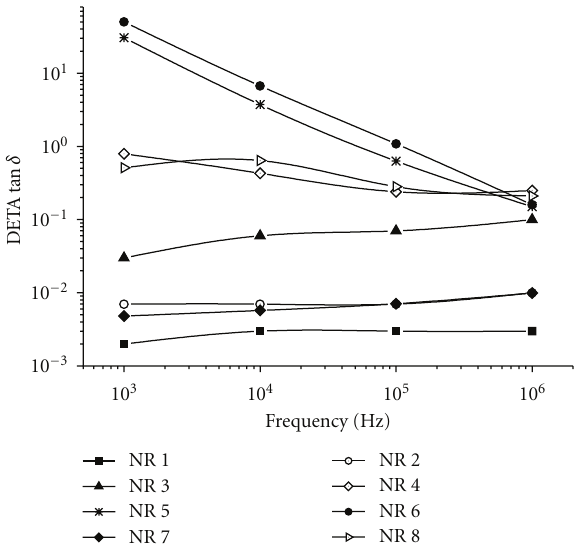
Figure 6: Frequency dependence of the dielectric loss angle tangent (DETA tan δ ) for composites comprising di ff erent amounts of Printex XE-2B or Corax N220 at 80 ◦